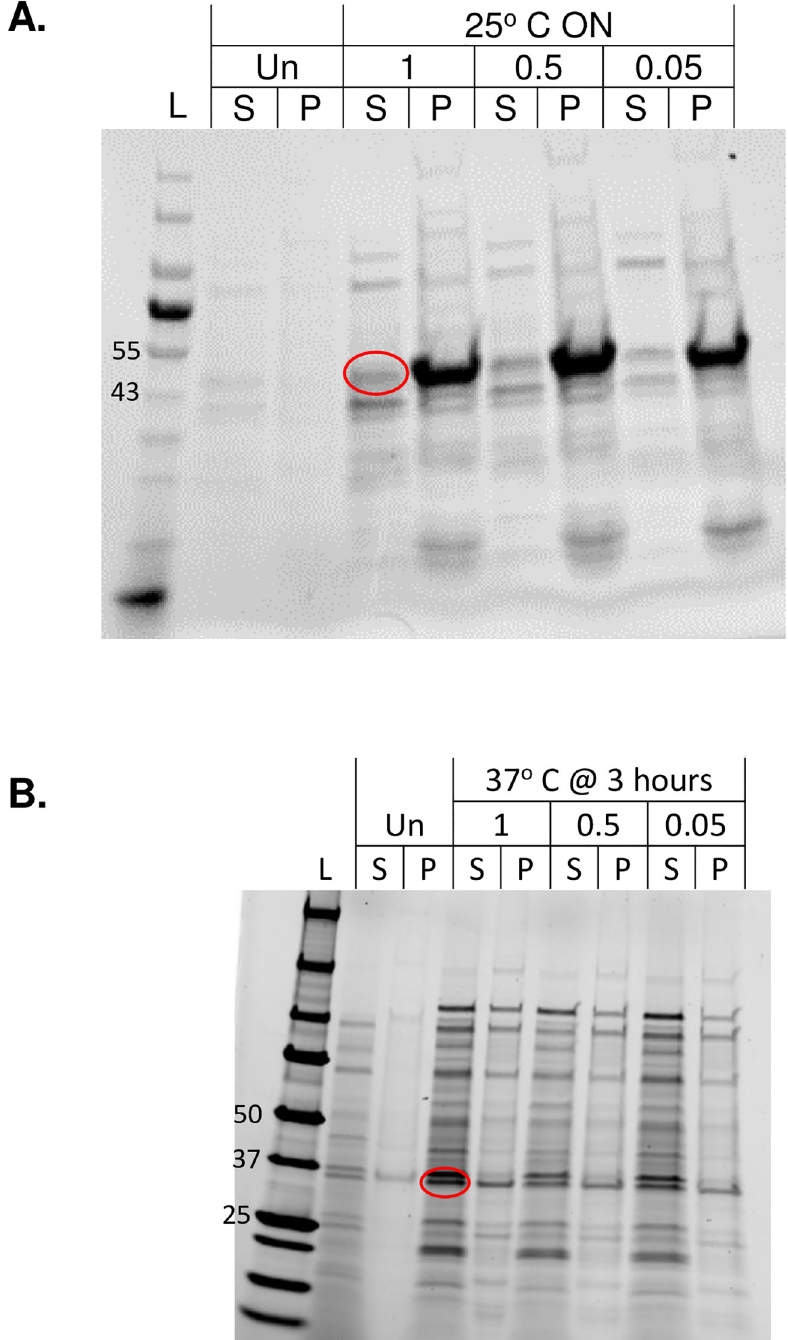
Fig 2. SDS-PAGE gels showing the effect of adding folding chaperones on expression. A) EGFR-KD and B) AurKA-KD expression in BL21 (DE3) complemented with folding chaperones showing a similar trend of equal soluble expression at different IPTG concentrations. (Raw gels are shown in S2 Fig, and letter abbreviations are the same as Fig 1).